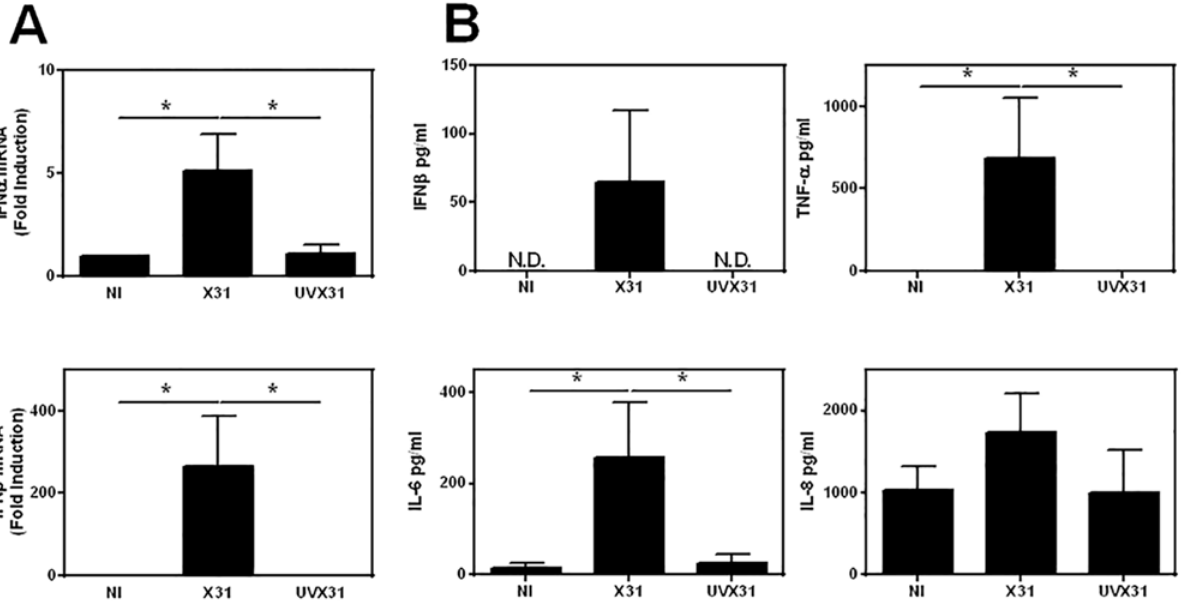
Fig 6. Effects of influenza infection on MDM cytokine expression. MDM were differentiated in the presence of 2 ng/ml GM-CSF for 12 d prior to infection with 500 pfu/ml of H3N2 X31 influenza virus or a UV-irradiated aliquot of virus (UVX31) for 2 h. After washing, media was replaced and the cells incubated for a further 22 h before supernatants and cells were harvested. Inflammatory cytokine expression was measured by A) real time PCR (IFN α , IFN β n = 6) and B) ELISA (IFN β , TNF α , IL-6, IL-8 n = 6) N.D. = not detected. PCR data were normalised to β 2MG and are expressed as mean fold induction over the non- infected (NI) sample ± SEM of 6 independent experiments. ELISA data are expressed as means ± SE of 6 independent experiments. Data analysed using a paired t-test. * p < 0.05, ** p <